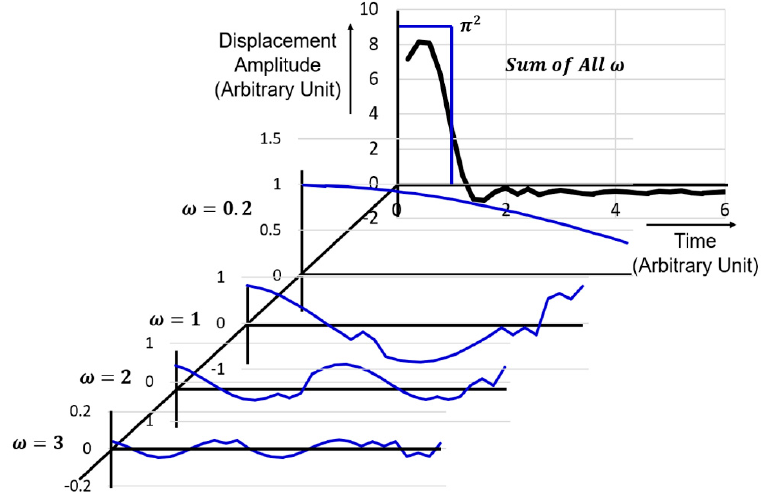
Figure 12. Phonon wave packet generation from the anharmonic lattice vibration. Taking into account a modified “phonon spectral density” (i.e., frequency square spectral